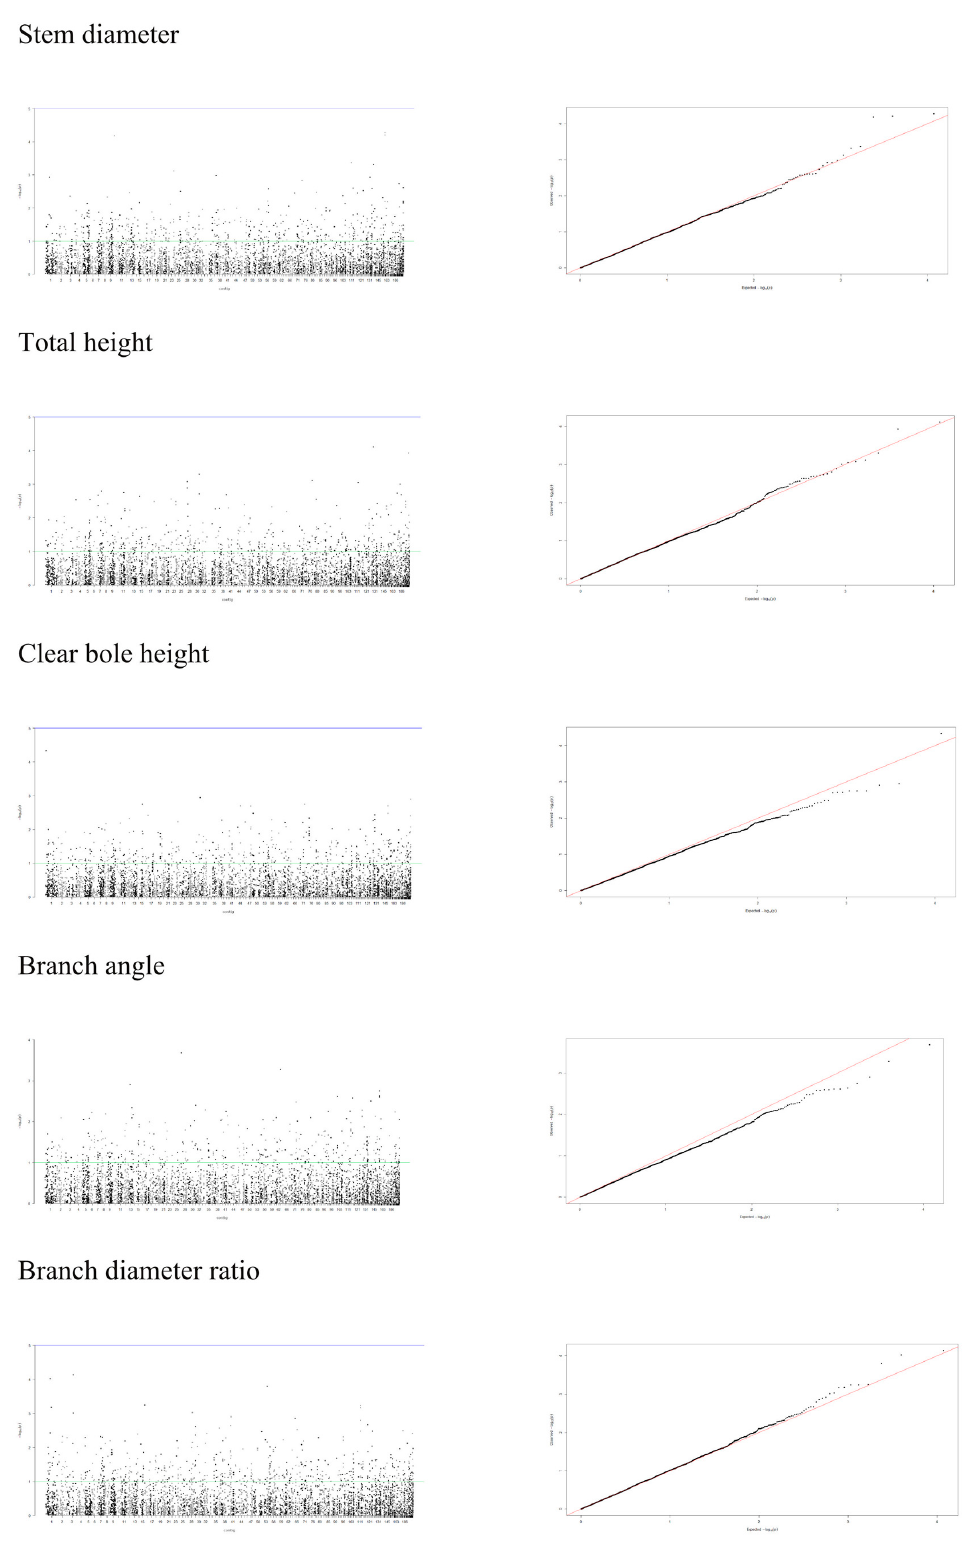
Figure 5. Manhattan and Q-Q plots for genome-wide association of S. platyclados growth traits (after thinning) and branch quality traits with SNP markers of Q + K model. The quantile-quantile plot indicates the fitness between expected (red lines) and observed p -values (black